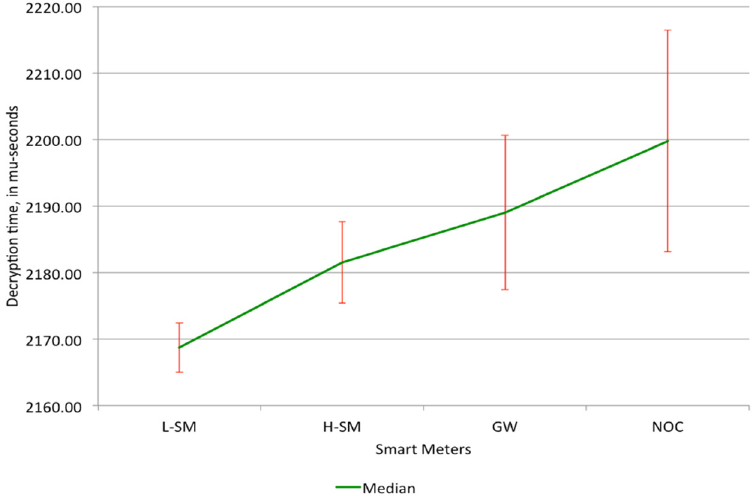
Figure 8. The output of the motes from the L-SM to NOC and back.